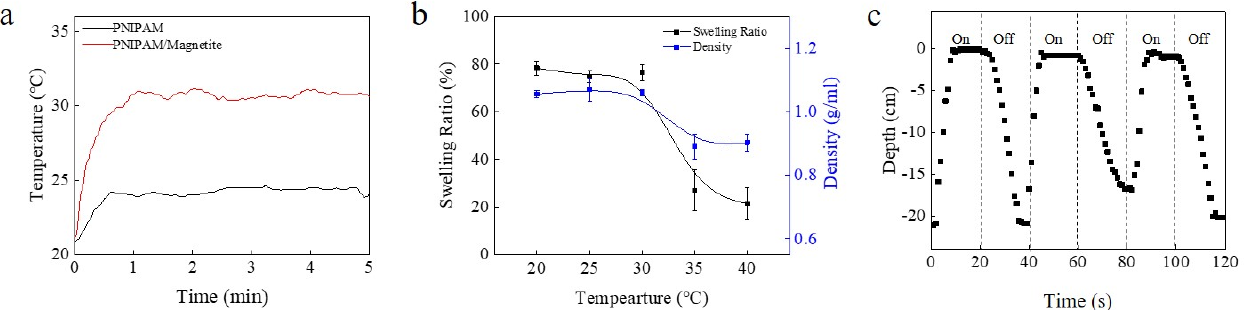
Figure 4. Diving/surfacing device stimulated by ultrasound. ( a ) Temperature change of PNIPAM and PNIPAM/magnetite composite heated by ultrasound. Device can be heated more with magnetite particle than when it consists of just PNIPAM. ( b ) Swelling ratio and density change of PNIPAM/magnetite composite diving/surfacing device. ( c ) Diving/surfacing cycles after the first cycle.